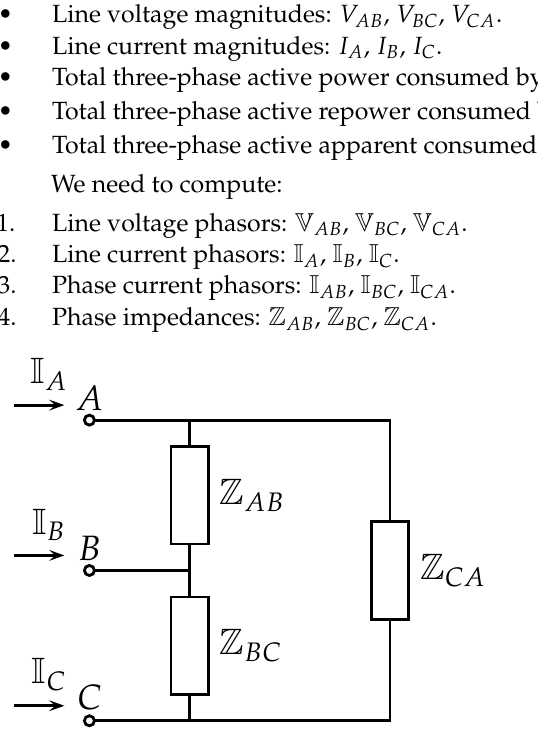
Figure A1. Problem statement